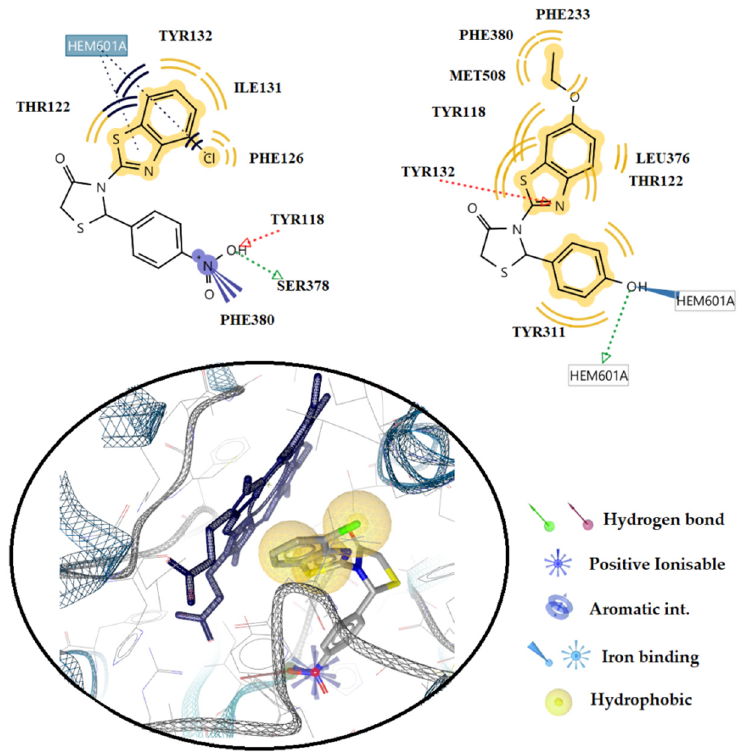
Figure 10. ( Top ) 2D diagrams of compounds 5 ( left ) and 16 ( right ) in the active site of C. albicans lanosterol 14alpha-demethylase (CYP51ca). ( Bottom ) Docking pose of compound 5 in the active site of the enzyme lanosterol 14alpha-demethylase of C. albicans (CYP51ca). Heme is represented in dark blue.